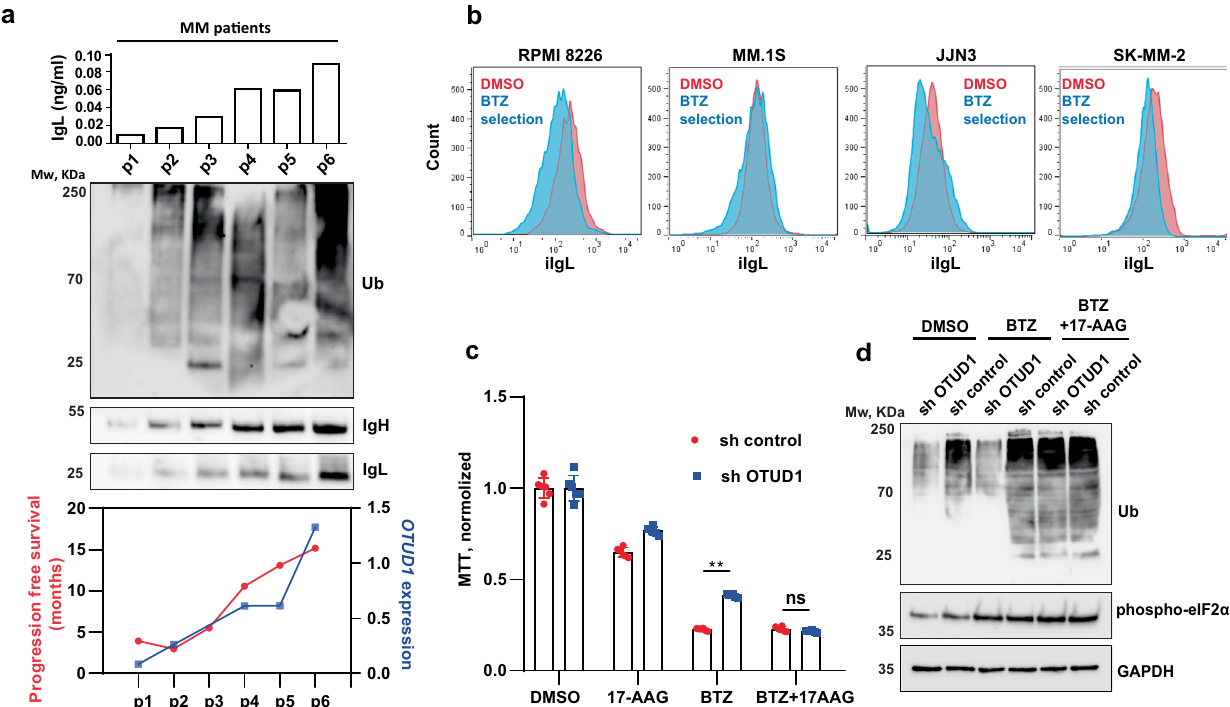
DMSO Fig. 7 | Inhibition of HSP90 overcomes PIs resistance in OTUD1 low myeloma. with Lambda-APC-C750 ™ (Cytognos) antibody. 10 4 events were collected in the a IgL concentration in aberrant plasma cells isolated using speci fi c myeloma panel LIVE/DEAD negative gate. c RPMI8226 cells stably expressing non-mammalian from newly diagnosed MM patients ( n =6) was quanti fi ed by ELISA (top graph). controlshRNA orshRNAtargeting OTUD1 wereexposed to vehicle (DMSO),10nM Levelsoftotalubiquitin, IgL,and IgHweredetected byimmunoblotting in primary BTZ,250nM17-AAGaloneor10nMBTZtogetherwith250nM17-AAGfor16h,and cell extracts (western blot). Expression of OTUD1 in primary cells was analyzed by viability was assessed using MTT assay. Signi fi cance was compared using the two- RT-PCR and plotted together with progression-free survival (PFS) (bottom graph). tailed Student ’ s t -test (BTZ p <0.0001, BTZ+17-AAG p =0.0669), ns non- All6patients(p1-p6)receivedbortezomib(BTZ)-basedtreatmentinthe fi rstlineof signi fi cant. Data are represented the mean±SD from 6 biological replicates. d The therapy. b 10 6 MMcellsweretreatedwith10nMBTZorDMSOascontrol.After16h amount of total ubiquitinated proteins in whole cell lysates from RPMI8226 cells cellswerewashedwithPBSandtransferredintofreshmediawithoutBTZ.Seventy- used in ( c ) was determined by western blotting (upper part) and the relative band twohourslatercellswerestainedwithAnnexin-Vandviablecellswerestainedwith intensities were quanti fi ed using ImageJ software and normalized to GAPDH load- LIVE/DEAD Fixable Blue Dead Cell Stain Kit (Invitrogen). Cells were fi xed and per- ing control (bottom meabilized using FIX & PERM Cell Permeabilization Kit (Invitrogen) and labeled